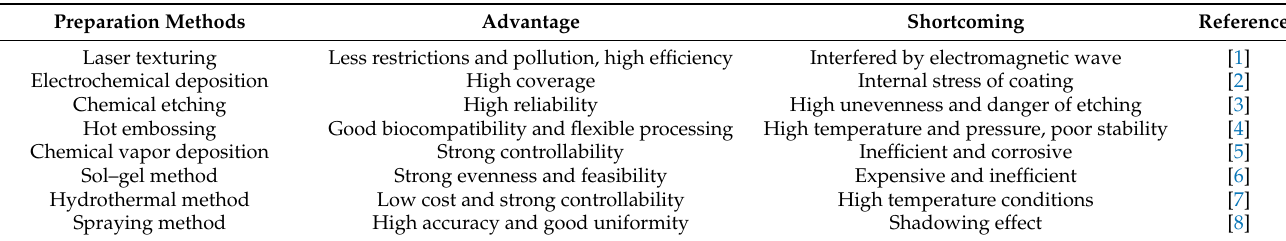
Table 1. Treatment methods of common corrosion